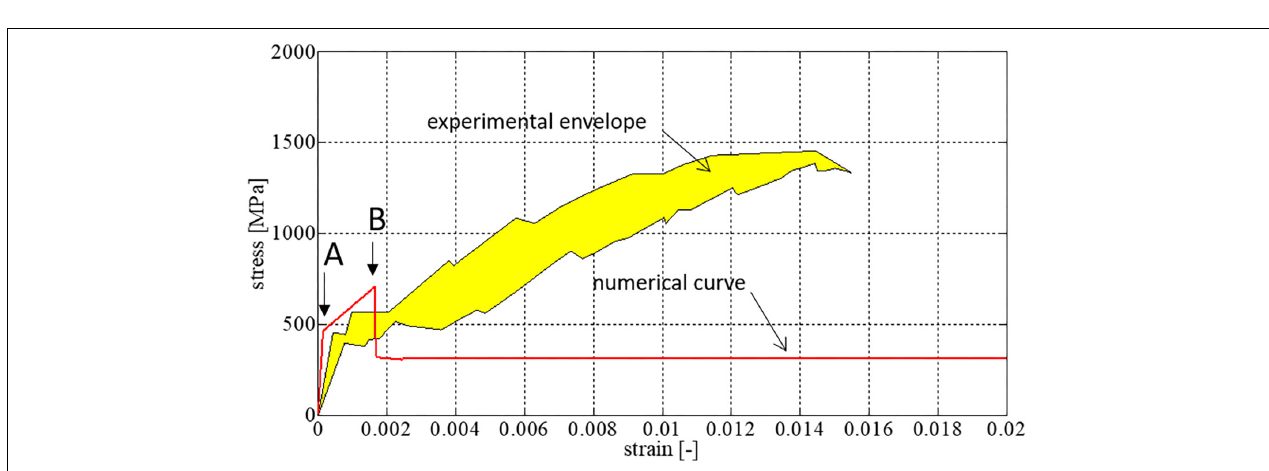
FIGURE 7 | Comparison between numerical and experimental stress-strain curves: clevis case modeled without the additional end elements.